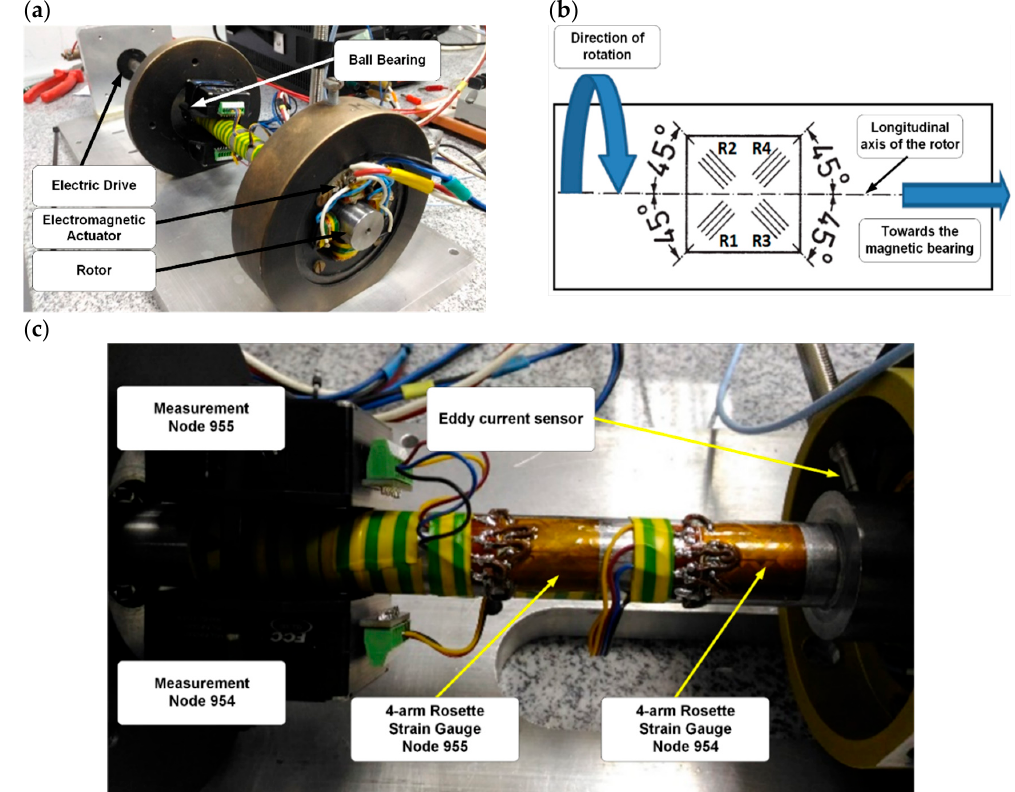
Figure 3. Laboratory stand of the active magnetic bearing with sensors: ( a ) laboratory model, ( b ) strain gauge configuration, ( c ) strain gauges with measurement nodes.